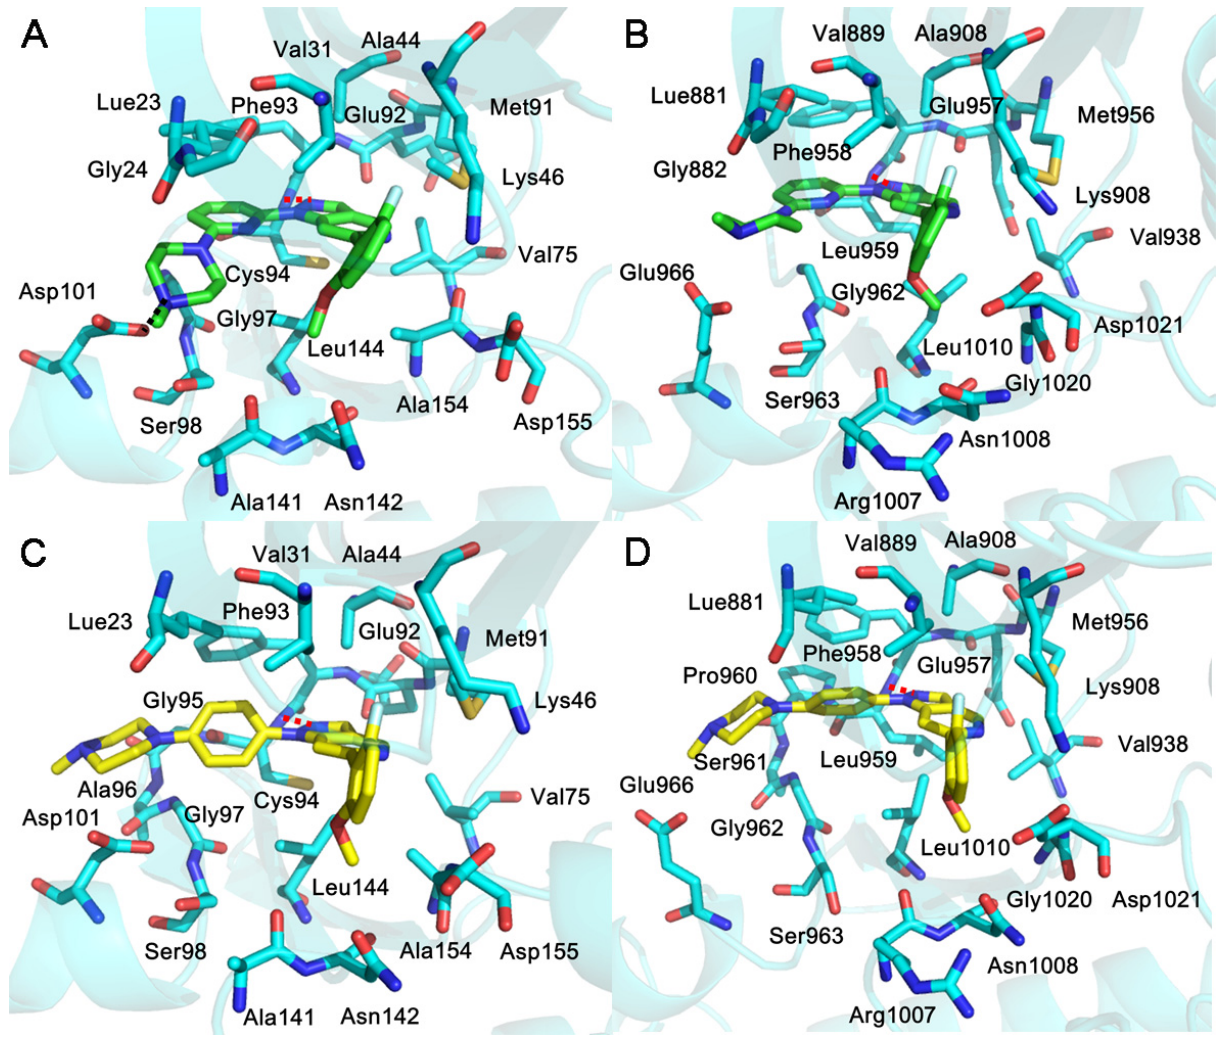
Figure 5. The binding mode of ( A ) HPK1-XHS ( B ) JAK1-XHS ( C ) HPK1-XHV ( D ) JAK1-XHV systems. The inhibitor XHS is shown as green sticks, the inhibitor XHV is shown as yellow sticks and the key residues of HPK1 and JAK1 kinase binding to inhibitors are shown as cyan sticks. Hydrogen bonds and salt bridges kinases and inhibitors are indicated by red and black dashes, respec- tively.